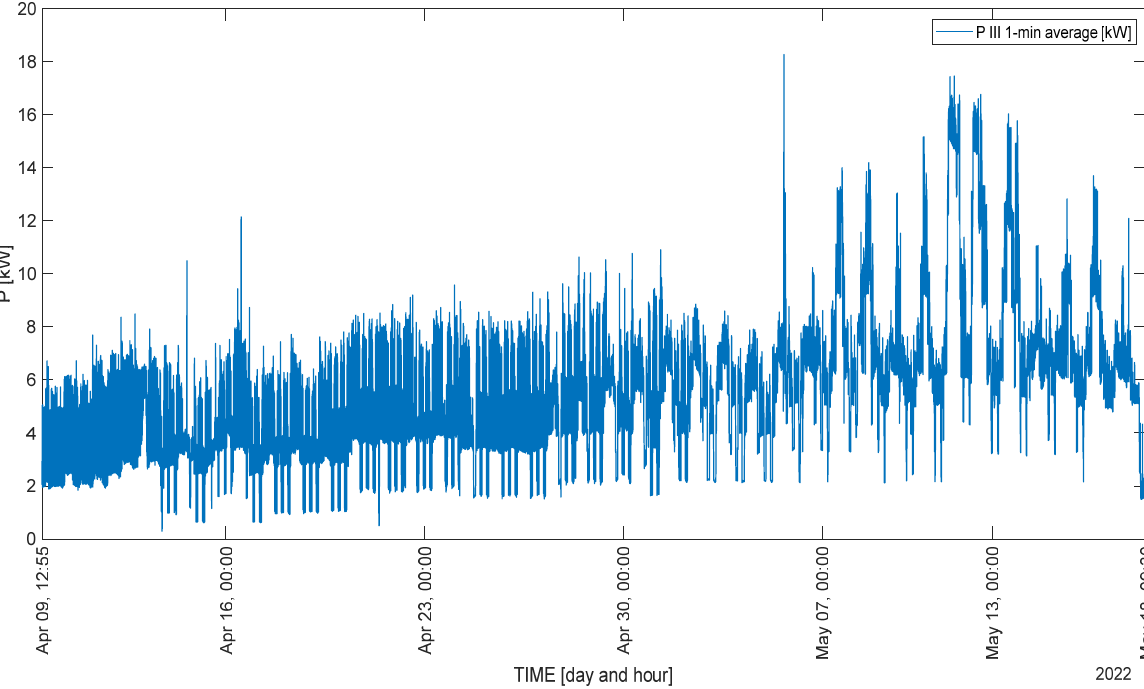
Figure 2. Three-phase active power consumed during the cycle. To assess the uniformity of the facility’s load, each stage of the cycle must be analyzed in detail. Detailed charts of three-phase active and three-phase reactive power are shown for cycle stage 1 (Figures 3 and 4), cycle stage 2 (Figures 5 and 6), and cycle stage 3 (Figures 7 and 8), respectively. The graphs also show charts averaged over 15 and 120 min intervals.